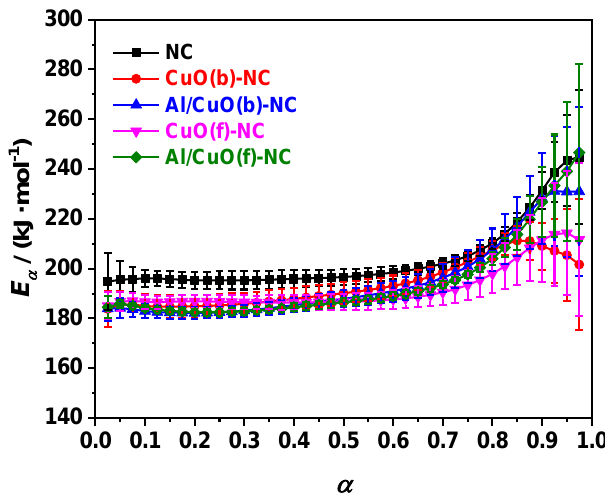
Figure 9. E α vs α curves of NC, CuO(b)-NC, Al / CuO(b)-NC, CuO(f)-NC, and Al / CuO(f)-NC by the isoconversional Flynn-Wall-Ozawa’s method.